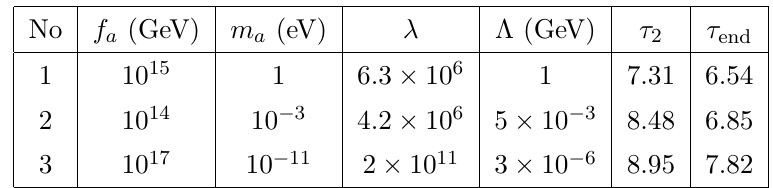
Table 1 . Sample values of { λ, Λ } that may induce sufficient friction to deplete the axion relic abundance to the observed one for a given choice of { m